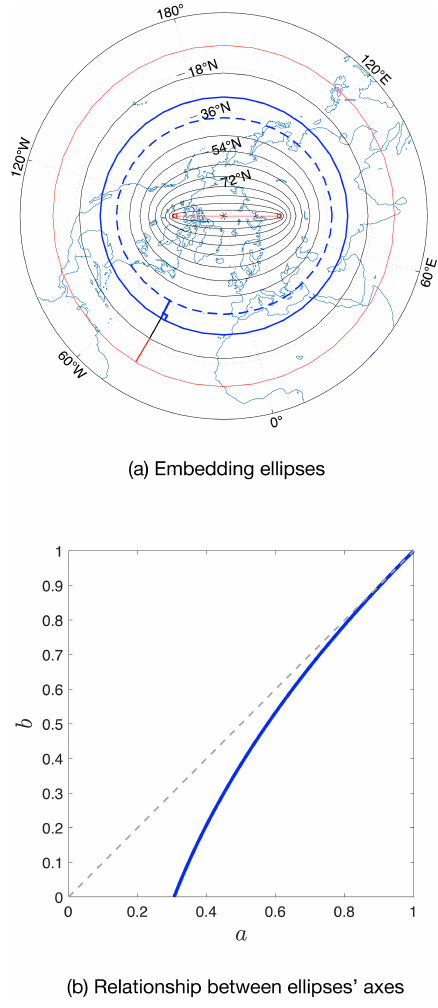
Figure A1. Construction of the embedding ellipses and the orthogo- nal grid. In panel (a) , we show in red the outermost ellipse (a circle) and the innermost ellipse (the direct link between the two grid poles marked by a red square). The numerical process of constructing an orthogonal grid is carried out between two adjacent ellipses, starting with points on the outermost ellipse and moving recursively down to the innermost one. The construction of a single step on the current ellipse (blue) to the next ellipse (dashed blue) is shown in panel (a) . In panel (b) , we show the relationship between the major axis and minor axis of the ellipses under a quadratic form (see Sect. A for